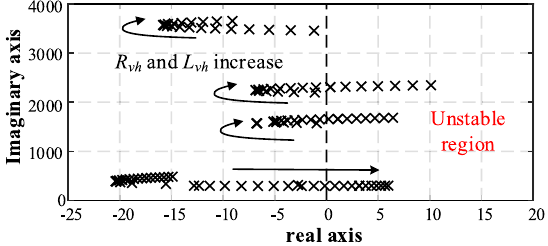
Fig. 12 Locus of poles of Y ( s ) as R vh and L vh vary